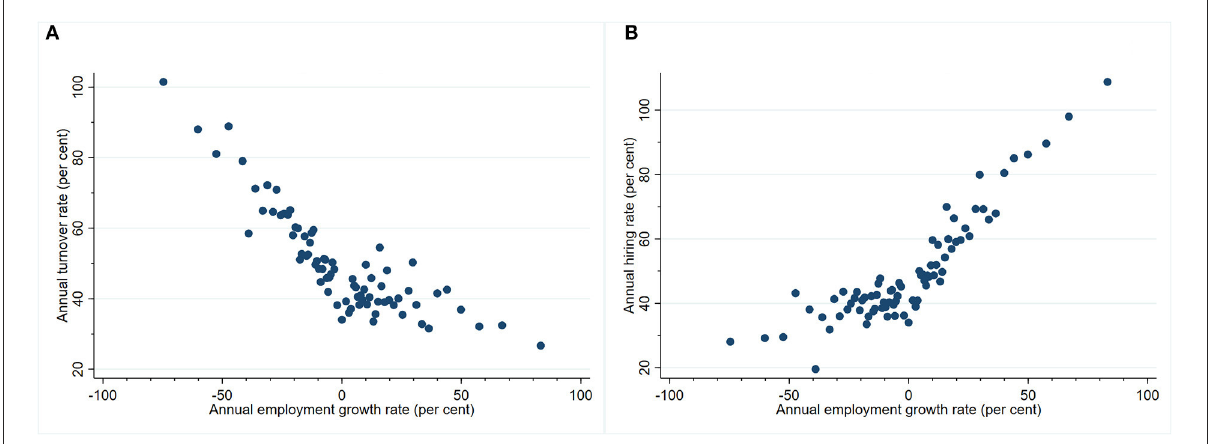
FIGURE1 (A) Relationship between care worker turnover and employment growth. (B) Relationship between care worker hiring and employment growth.